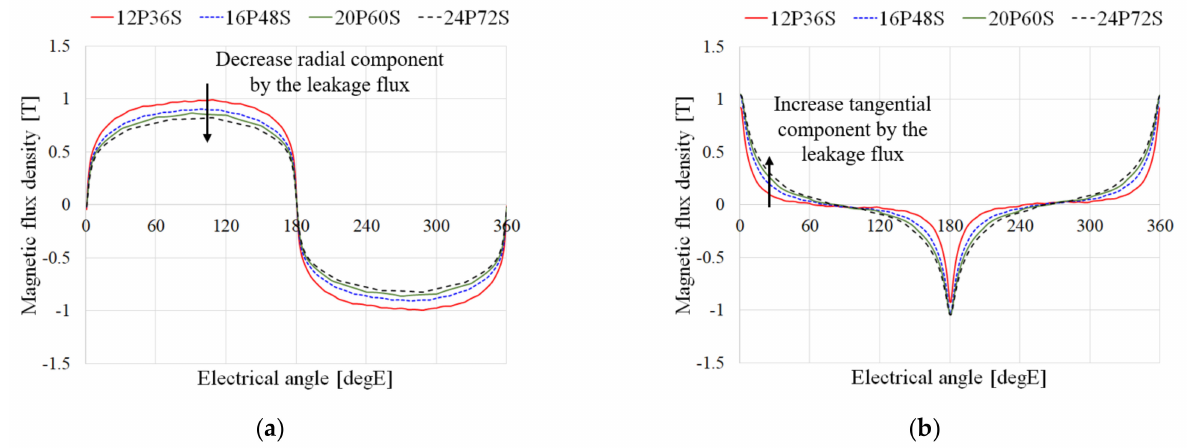
Figure 5. Airgap magnetic flux density according to pole slot combinations: ( a ) radial component; ( b ) tangential component.